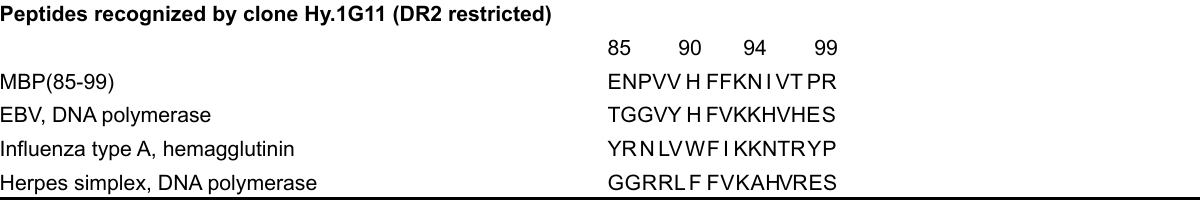
Table 2. Sequence alignment of viral/bacterial mimicry peptides that stimulate MBP-specific T cell clones that are DQ1 or DR2 restricted [9] ( continued )